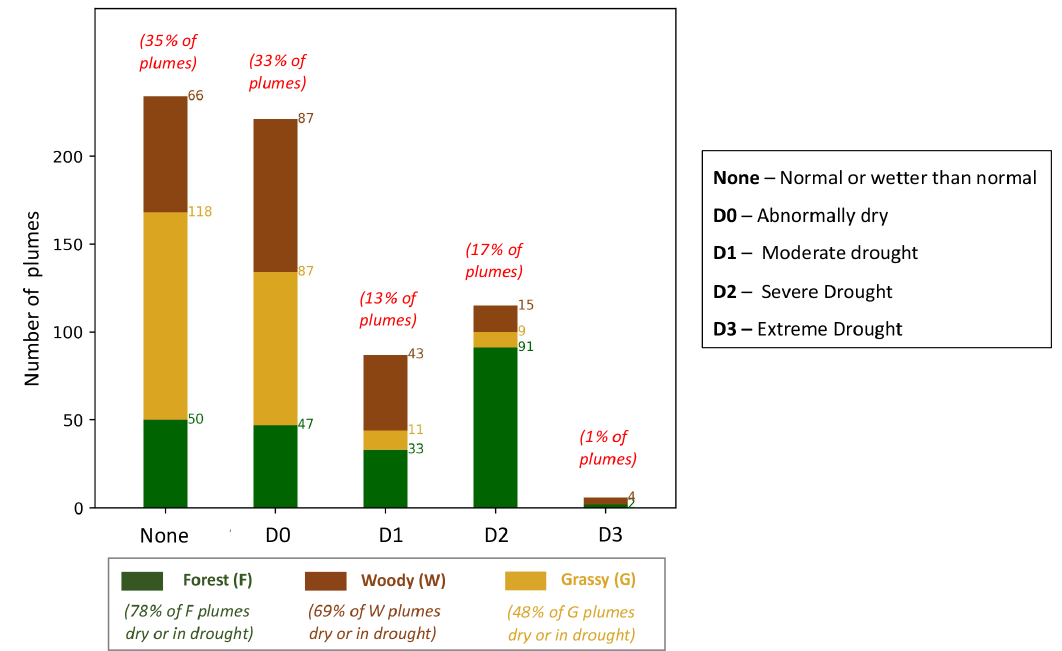
Figure 7. The number of plumes observed in each drought category (see key), colored by plume type.